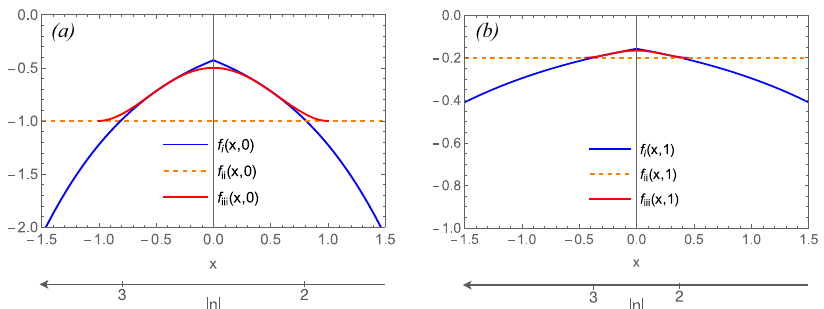
ffiffiffiffiffiffi p αβ for two values of y ¼ β 0 = β : y = 0